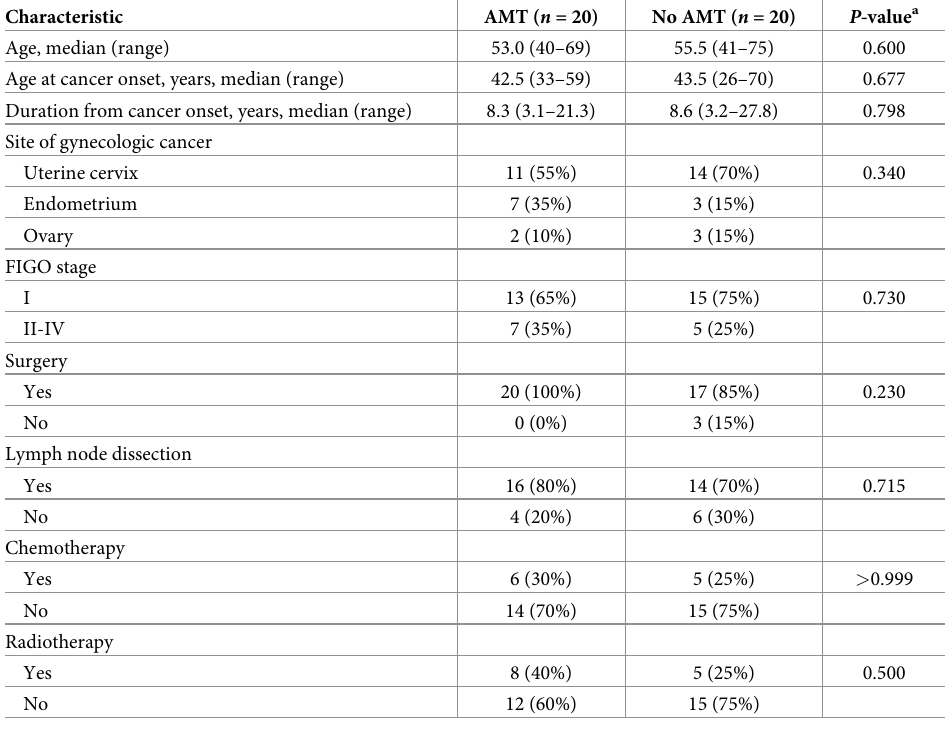
Table 1. Demographics and baseline characteristics of cancer